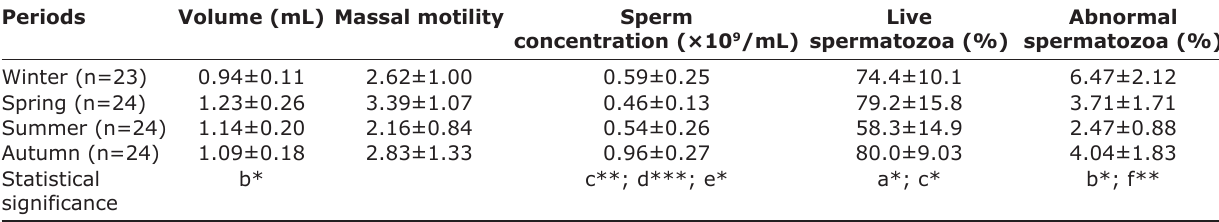
Table-2: Seasonal variations of spermatic parameters (volume, massal motility, sperm concentration, live and abnormal spermatozoa).